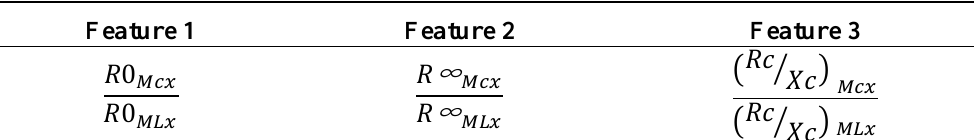
Table 3. Feature